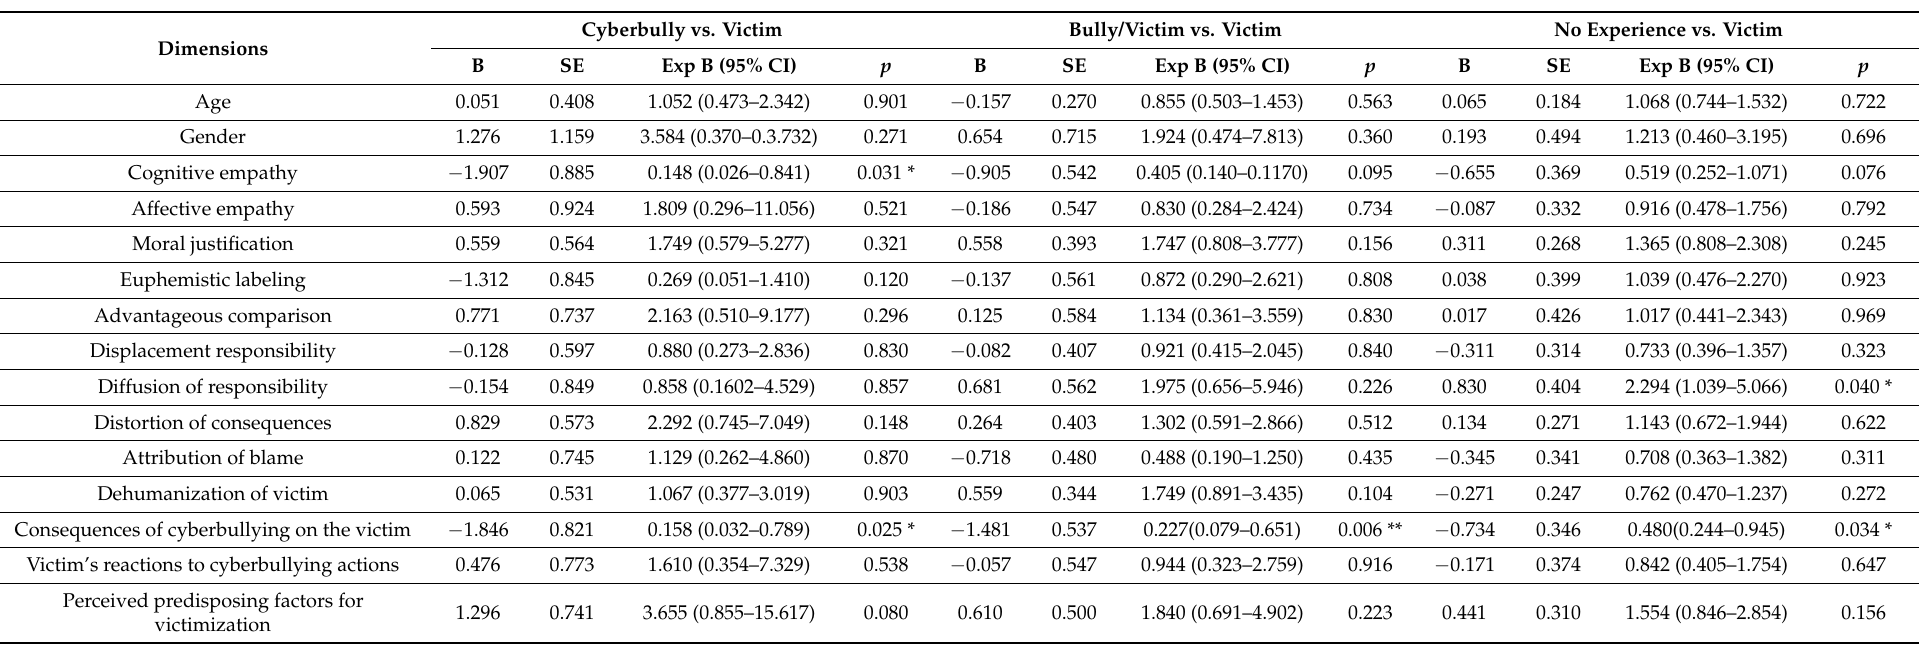
Table 3. Multinomial logistic regression coefficients defining the effect of the investigated dimensions on the personal experience of cyberbullying. Cyberbully vs. Victim Bully/Victim vs. Dimensions